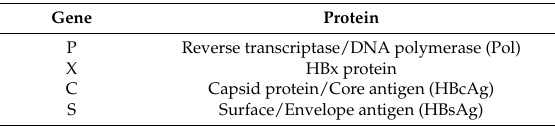
Table 1. Genes and Proteins encoded by Hepatitis B Virus (HBV).